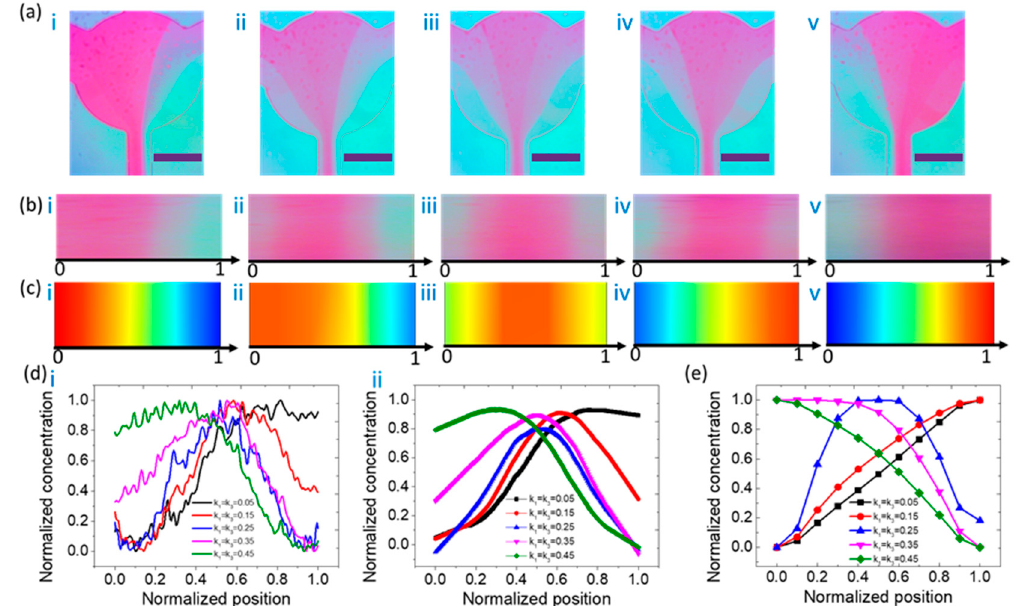
Figure 3. ( a ) Experimental results of the concentration distribution at the outlet of the microfluidic device. From left to right, i denotes the case of k 1 = k 3 = 0.05; ii denotes the case of k 1 = k 3 = 0.15; iii denotes the case of k 1 = k 3 = 0.25; iv denotes the case of k 1 = k 3 = 0.35; and v denotes the case of k 1 = k 3 = 0.45. The scale bar is 200 μ m. The concentration matrix is C = (0, 1, 1, 0). ( b ) Partial enlarged view of the mass concentration of the outlet corresponding to (a). ( c ) Numerical simulation results of the concentration distribution at the outlet of the microfluidic device. From left to right, the flow ratios are shown in the cases of i to v. ( d ) Experimental results of normalized concentration as a function of normalized position at the outlet of the microfluidic device, whose pattern is like a bell-type curve. A smoothing process technique was adopted from i to ii. ( e ) Numerical simulation results of normalized concentration as a function of normalized position at the outlet of the microfluidic device.